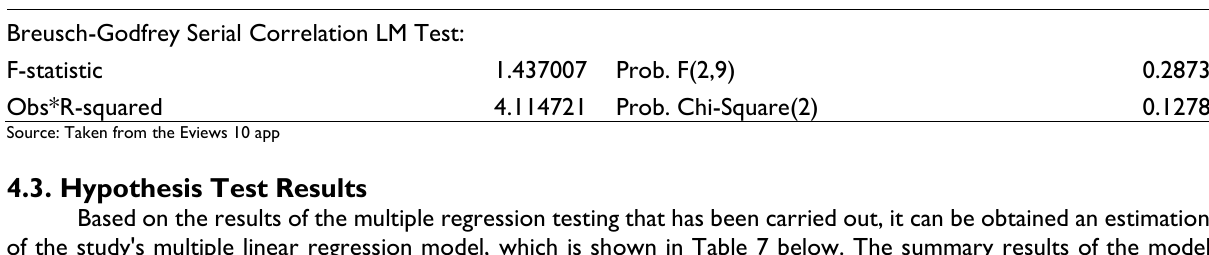
Table 6. Autocollinearity test results